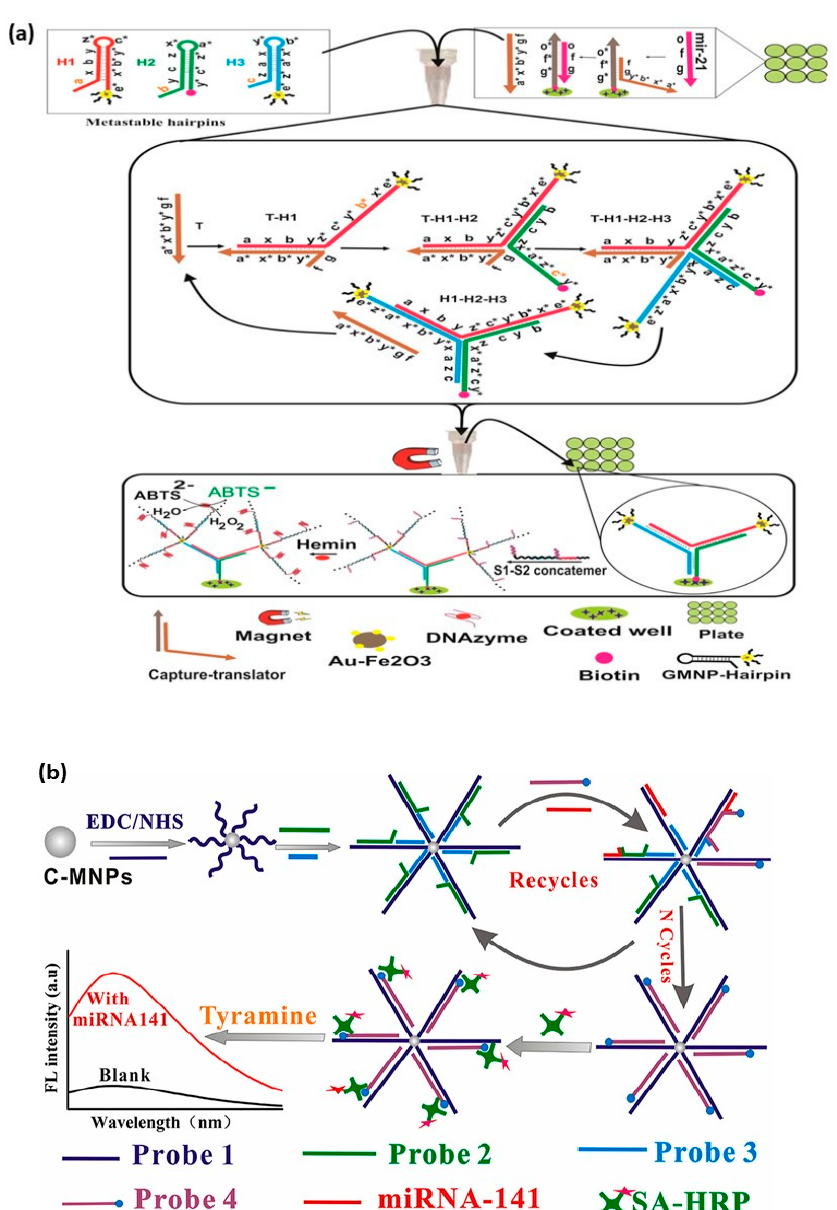
Figure 4. MNP-based ( a ) Colorimetric-based optical biosensor platform. H1 and H3 are GMNP-labeled, while H2 is biotinylated. The segments that are exposed and involved in the serial reactions required for the formation of the targeted nanostructure are shown with “*”. [Reproduced with the permission of [173] Copyright 2019 Published by Elsevier B.V.]; ( b ) Fluorescence-based platform optical biosensor platform [Reproduced with the permission of [179] Copyright 2019 Published by Elsevier B.V.].